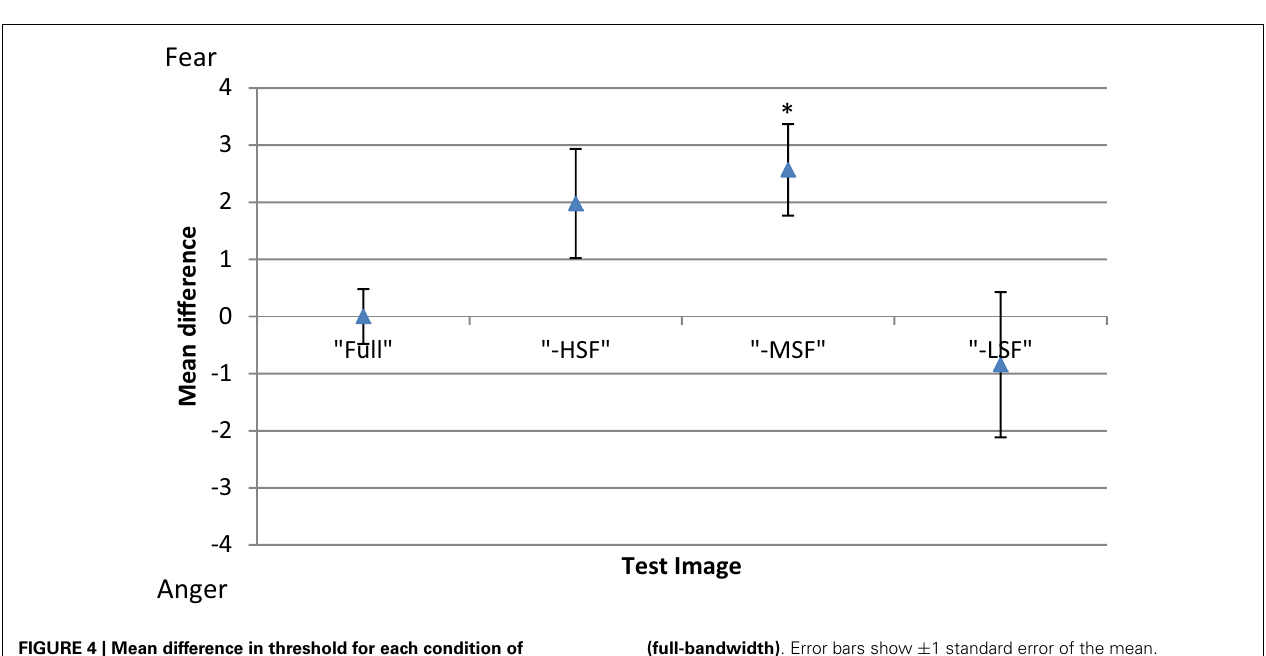
FIGURE 4 | Mean difference in threshold for each condition of test image type (full-bandwidth, -HSF, -MSF, and -LSF); with respect to the mean threshold of the control condition